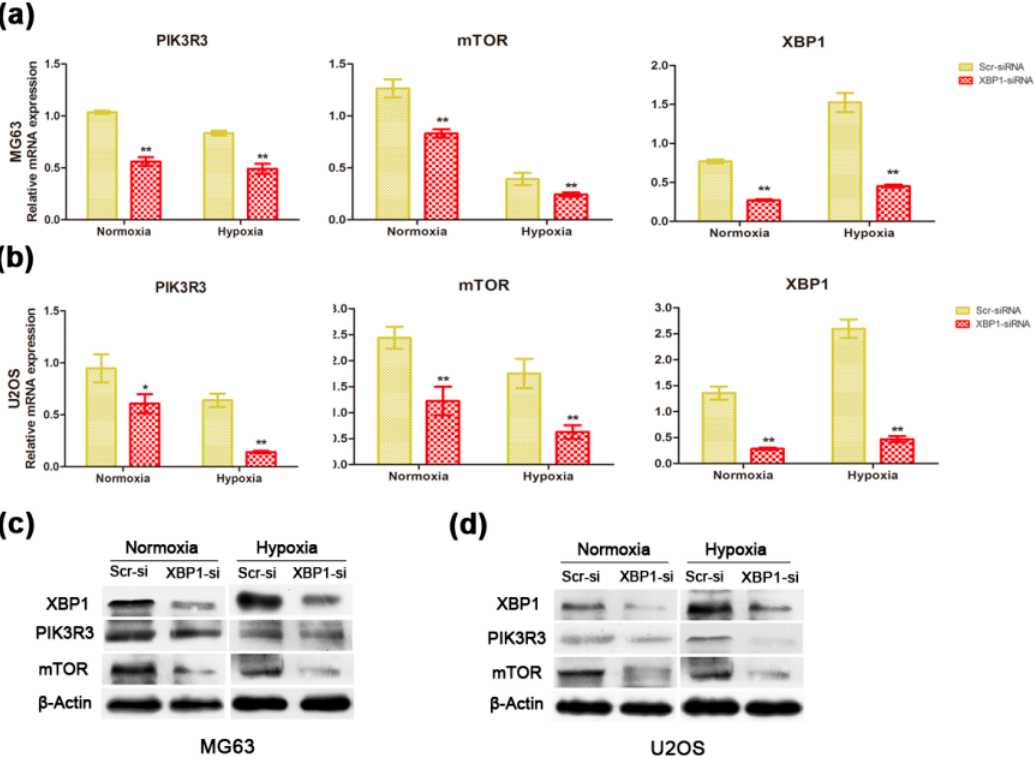
Figure 5. Down-regulation of PIK3R3 and mTOR after inhibiting the expression of XBP1 . ( a , b ) The mRNA expression of PIK3R3, mTOR, and XBP1 between the scrambled and XBP1-knockdown group under both normoxic and hypoxic condition in MG63 and U2OS cells; ( c , d ) The protein expression of PIK3R3, mTOR, and XBP1 between the scrambled and XBP1-knockdown group under both normoxic and hypoxic condition in MG63 and U2OS cells. Transfection efficacy of XBP1-siRNA was confirmed by qRT-PCR and Western blot assays. The data are representative of three independent experiments. Error bars represent mean ± s.d. * p < 0.05, ** p < 0.01 by Student’s t -test.